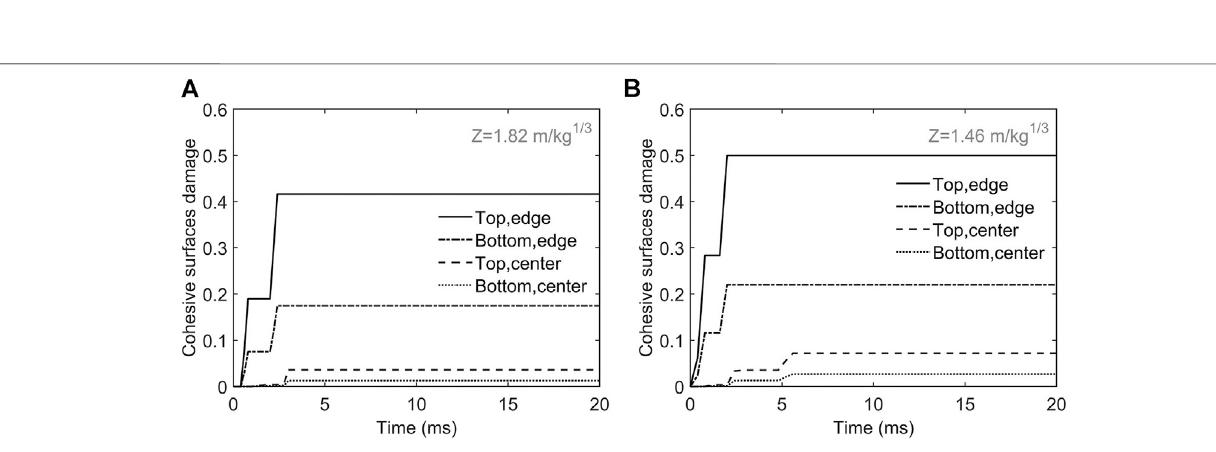
Frontiers in Materials |